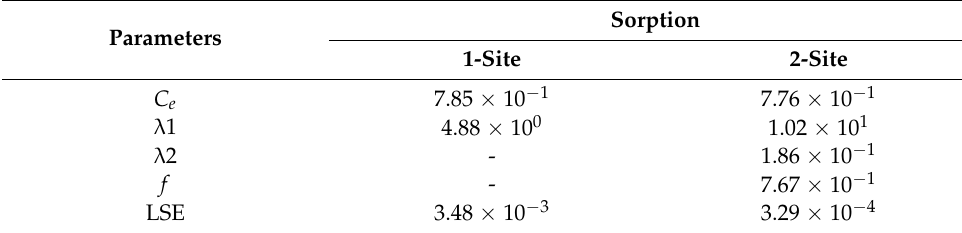
Table 3. Langmuir fitting parameters for sorption of Se on TMS